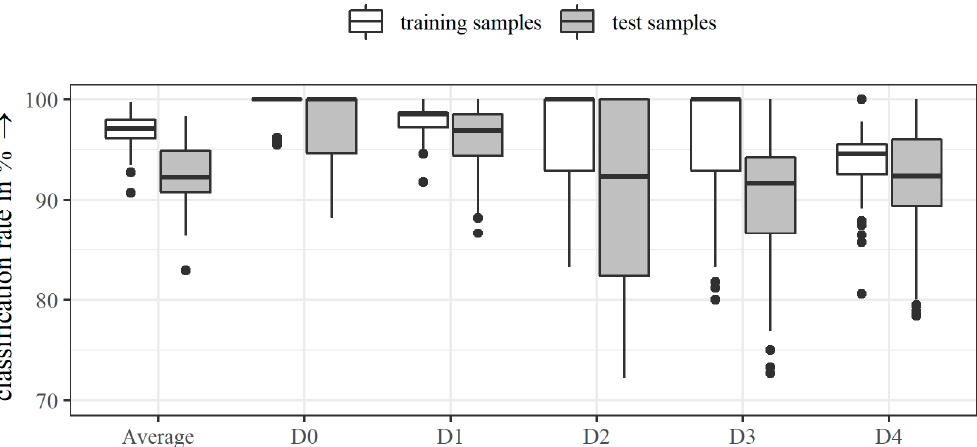
Figure 10. Robustness for the classification of 360 emission profiles; 100 repetitions, with random splits into 50% training samples and 50% test samples; box whisker plots of average and per class classification rates for training samples (white) and test samples (grey).